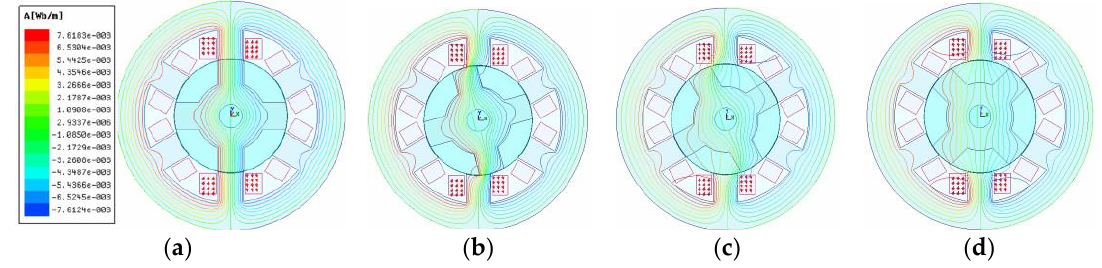
Figure 1. The finite element method (FEM) analysis model of the switched reluctance motor (SRM) with the magnetic flux (I = 8 A): ( a ) θ = 0°; ( b ) θ = 15°; ( c ) θ = 30°; ( d ) θ = 45°.